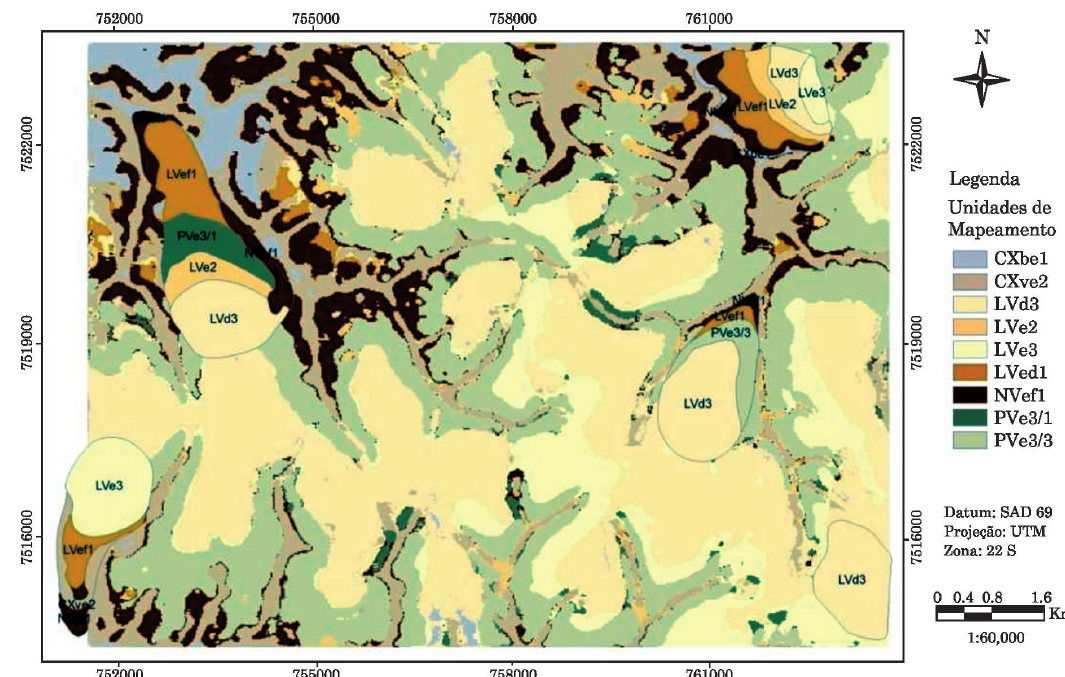
Figura 2. Unidades de mapeamento nas cinco áreas de referências e mapa digital de